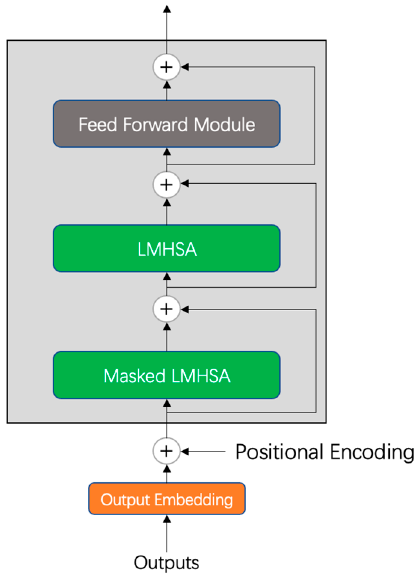
Figure 2. Low-rank decoder structure diagram.